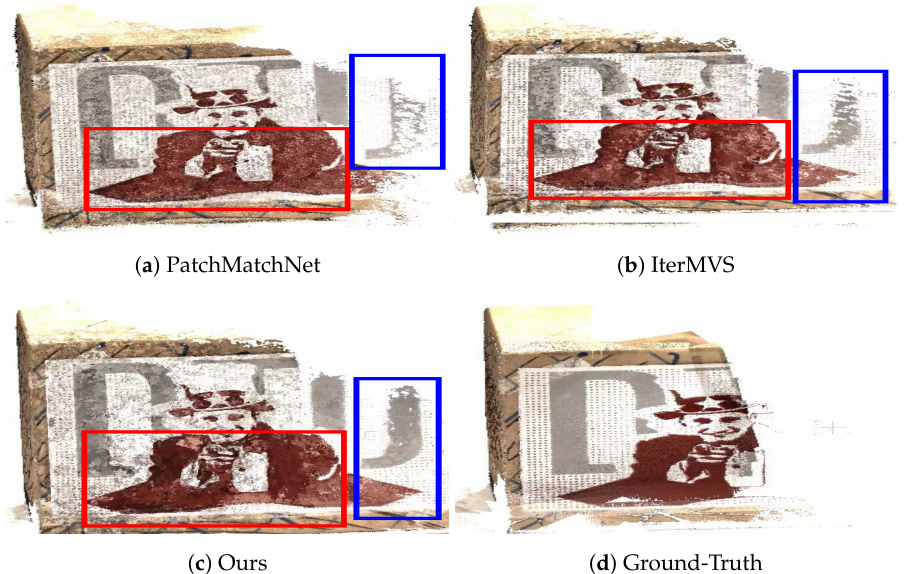
Figure 6. Point reconstruction of scan13 on DTU evaluation dataset.